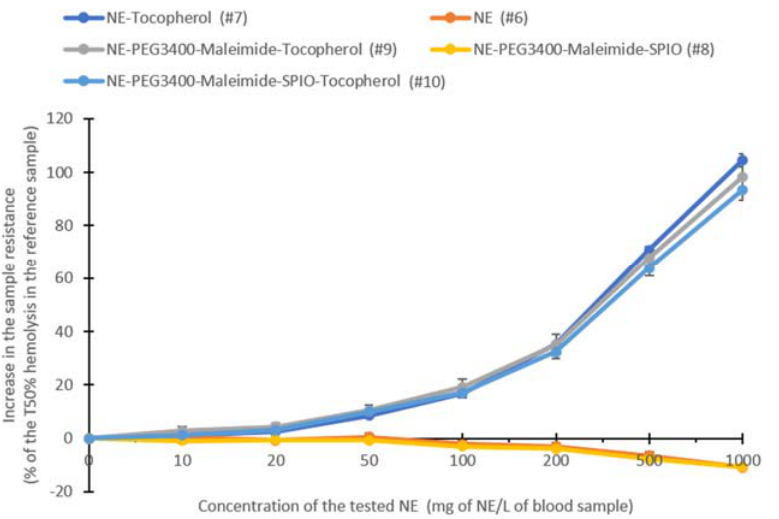
Figure 7. “Kit Radicaux Libres” test (KRL test) to determine the antioxidant properties of